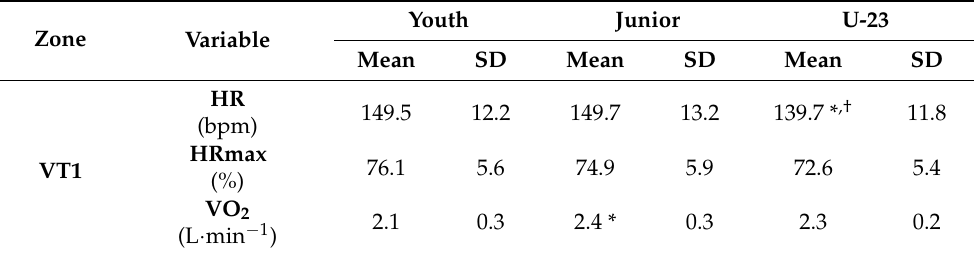
Table 2. Performance assessments